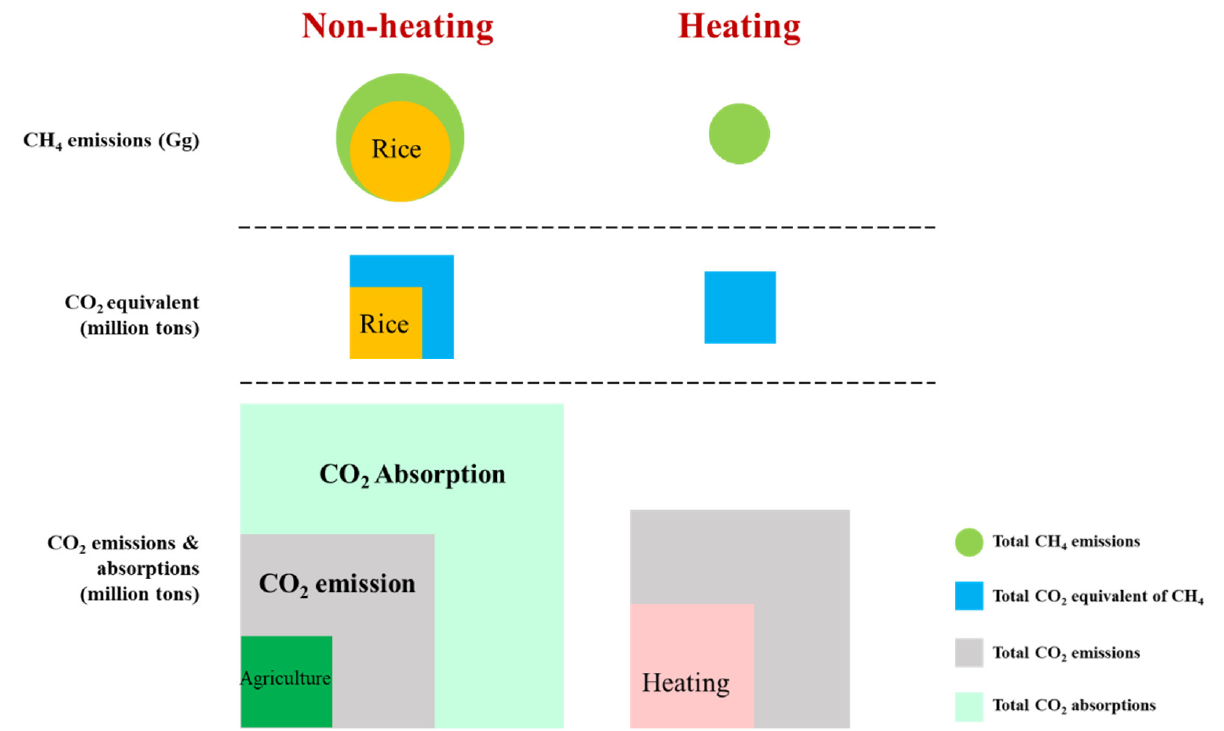
Figure 8. Contribution of CH 4 to local GHGs emissions (heating period vs. non-heating period) .